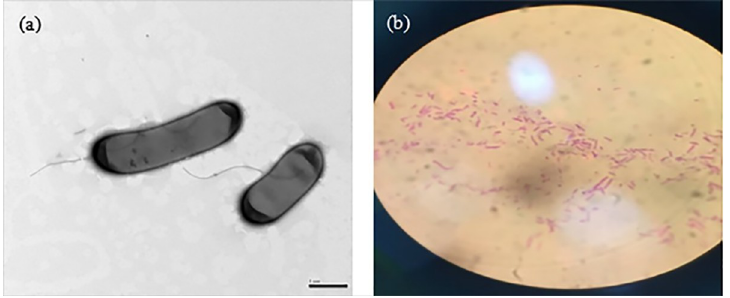
Fig 2. Morphological characteristics of the strain. (a) TEM image of the strain; (b) Gram-stained image of the strain.